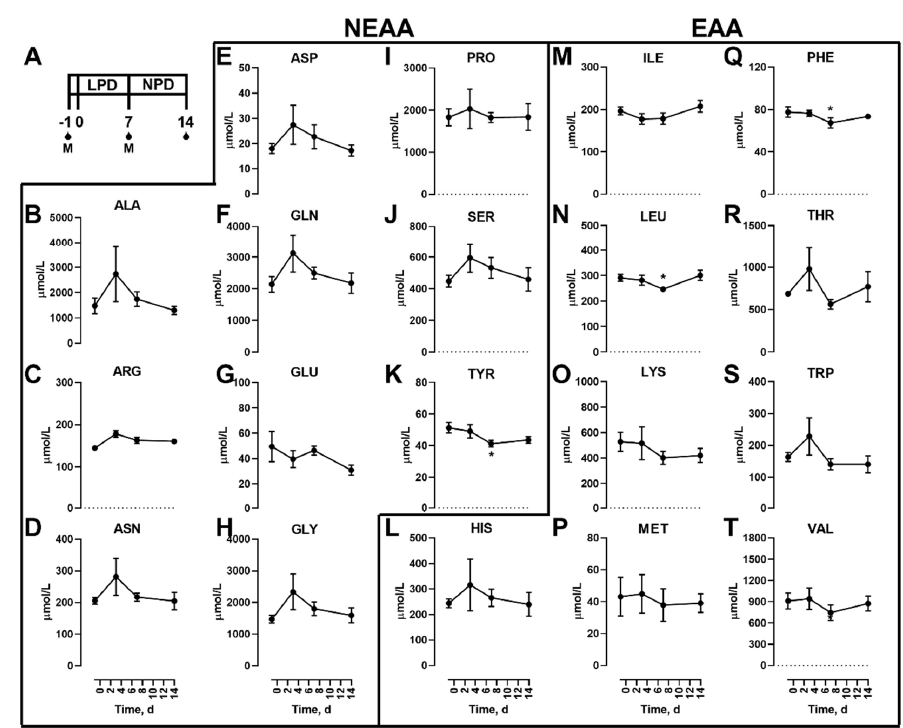
Figure 1. E ff ects of dietary protein restriction on blood serum proteinogenic amino acids during fasting. After an initial sample, young men ( n = 5) underwent a 7 d period of consuming a